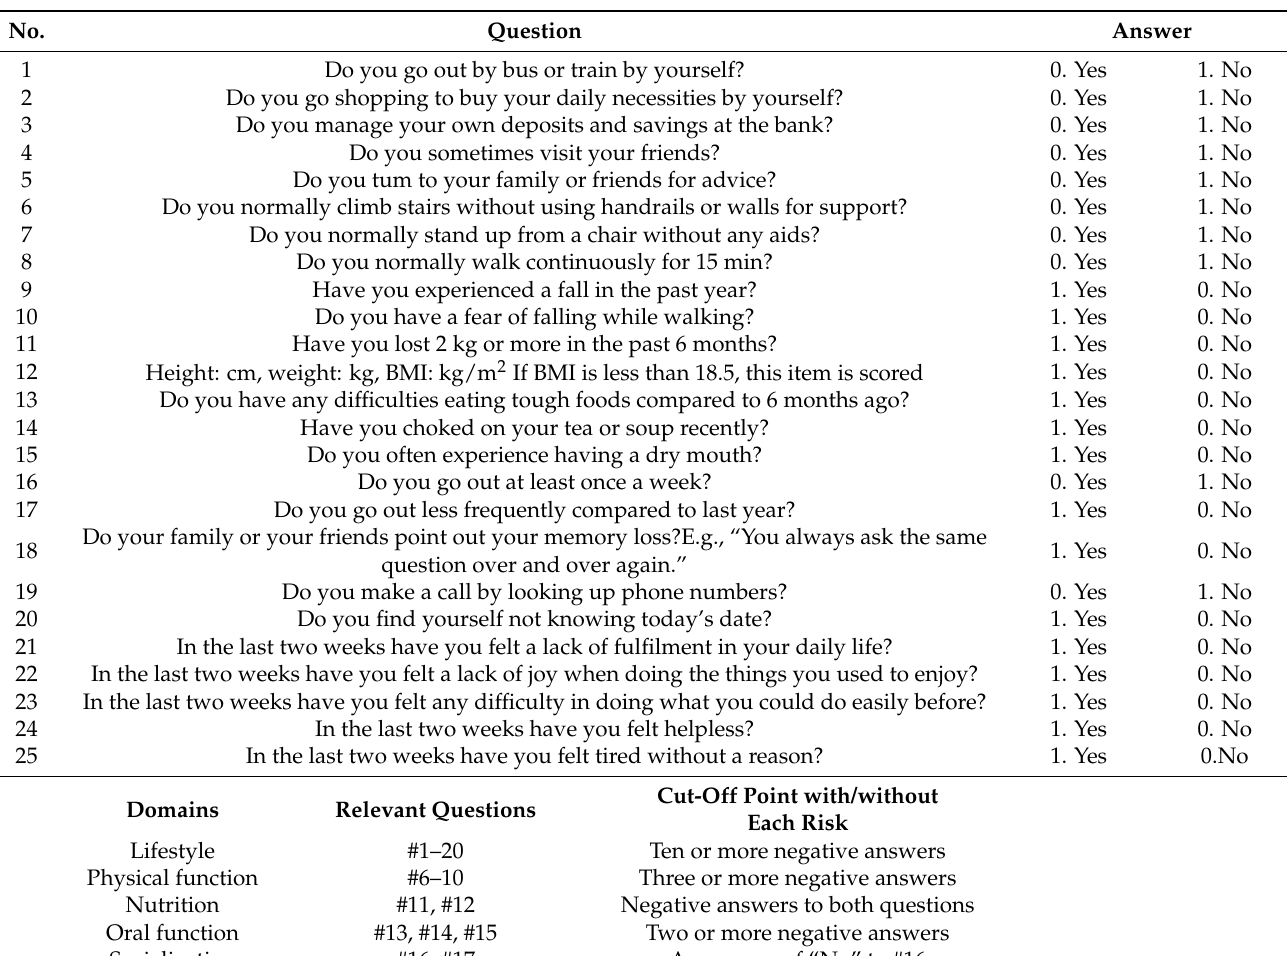
Table 1. Kihon Checklist ( top ) and its seven domains ( bottom